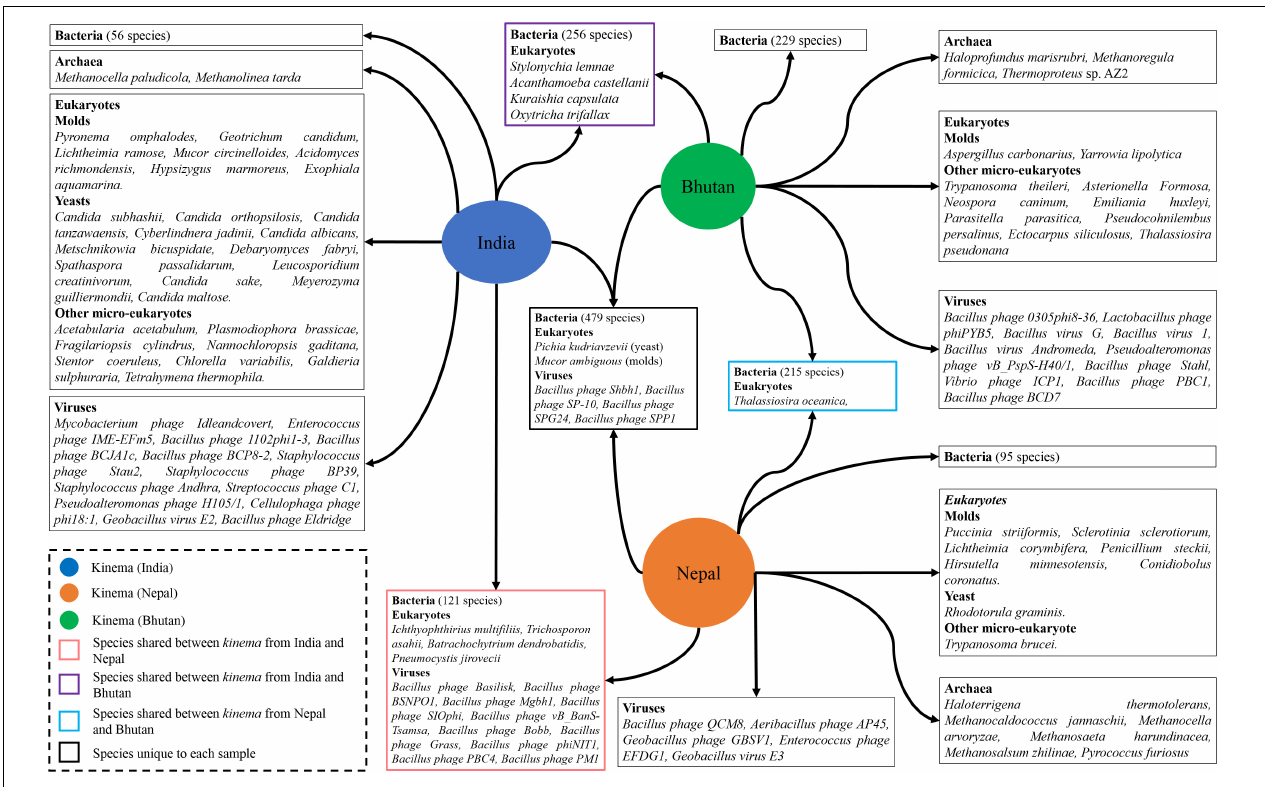
FIGURE 4 | Representation of shared and unique species identified from different domains in kinema